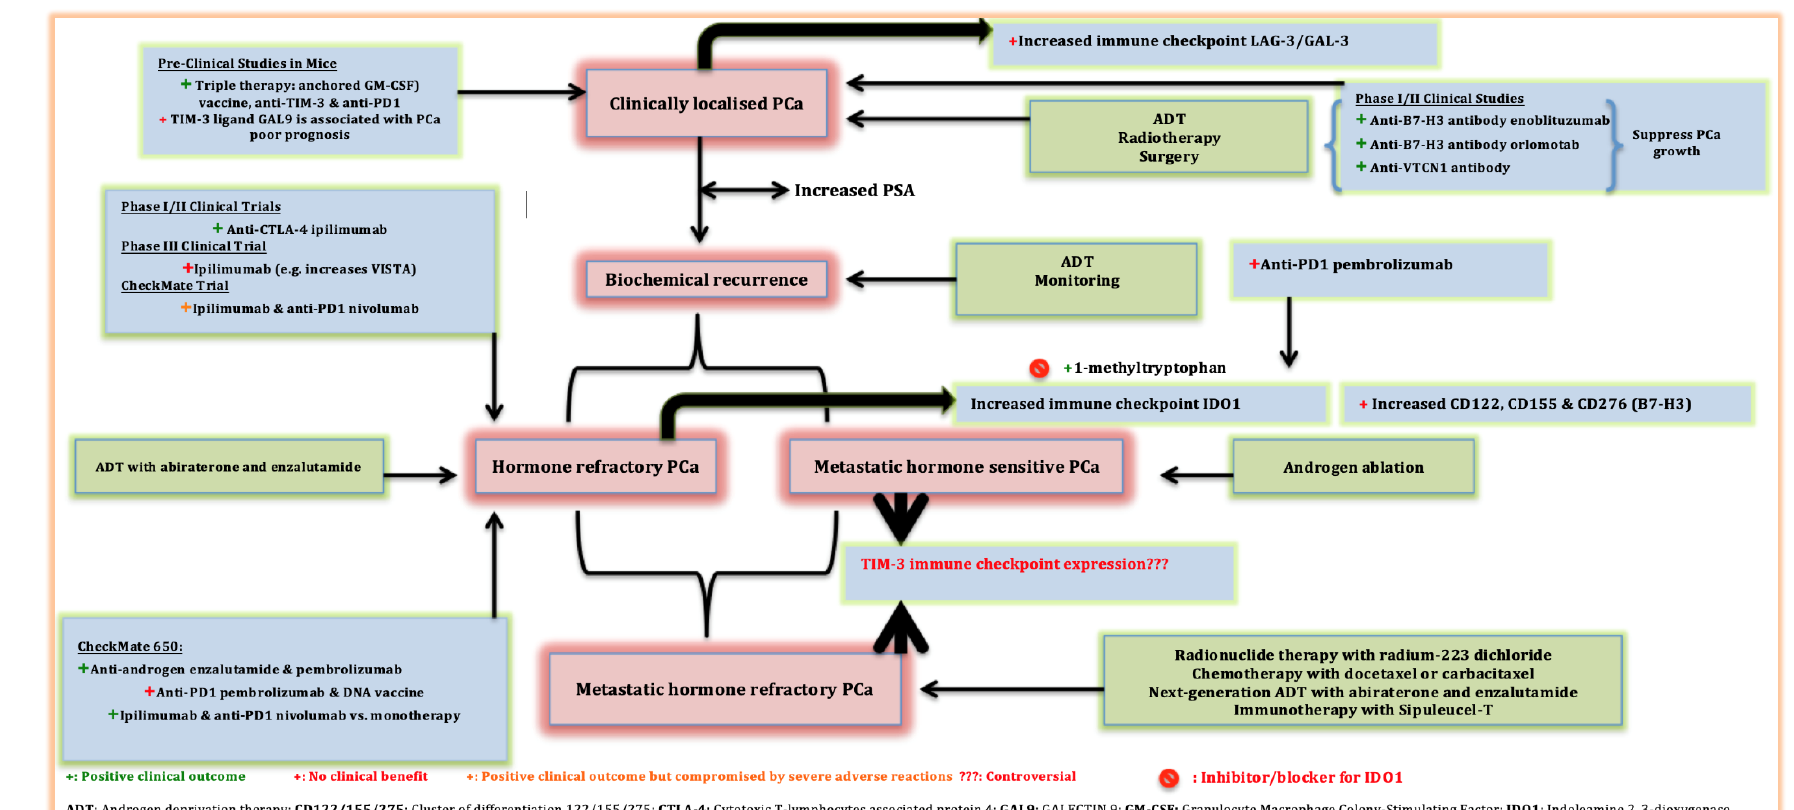
Figure 2. Clinical disease progression, pathophysiology and current therapeutic interventions of prostate cancer. Most PCa patients usually progresses slowly to mHRPC or mHSPC. PCa treatment varies according to stages and pathophysiology of the disease, and these currently include chemotherapy, radiotherapy, surgery and ADT. Various preclinical and clinical trials have been tested for immunotherapy approaches targeting various immune checkpoints although these have demonstrated minimal clinical benefit in PCa especially when used as monotherapies. Bold arrows represent immune checkpoints that can potentially be targeted for therapy. Color codes: pink boxes—clinical disease progression; green boxes—established therapy strategies; blue boxes—novel therapy option.